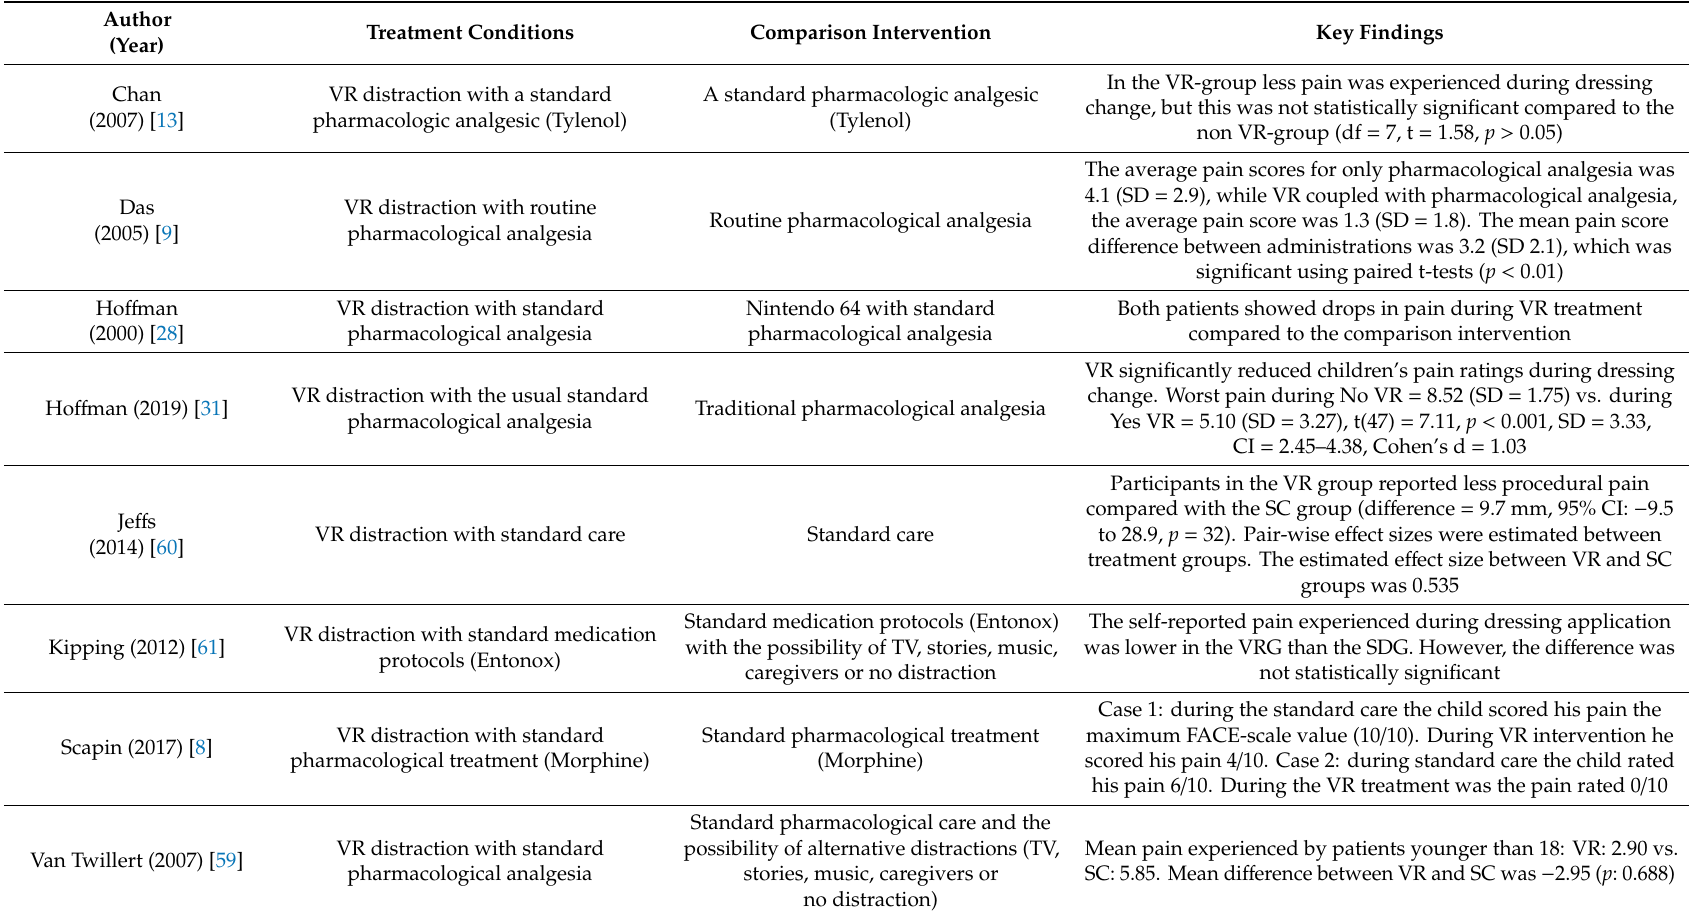
Table A3. Summary of findings for the included studies